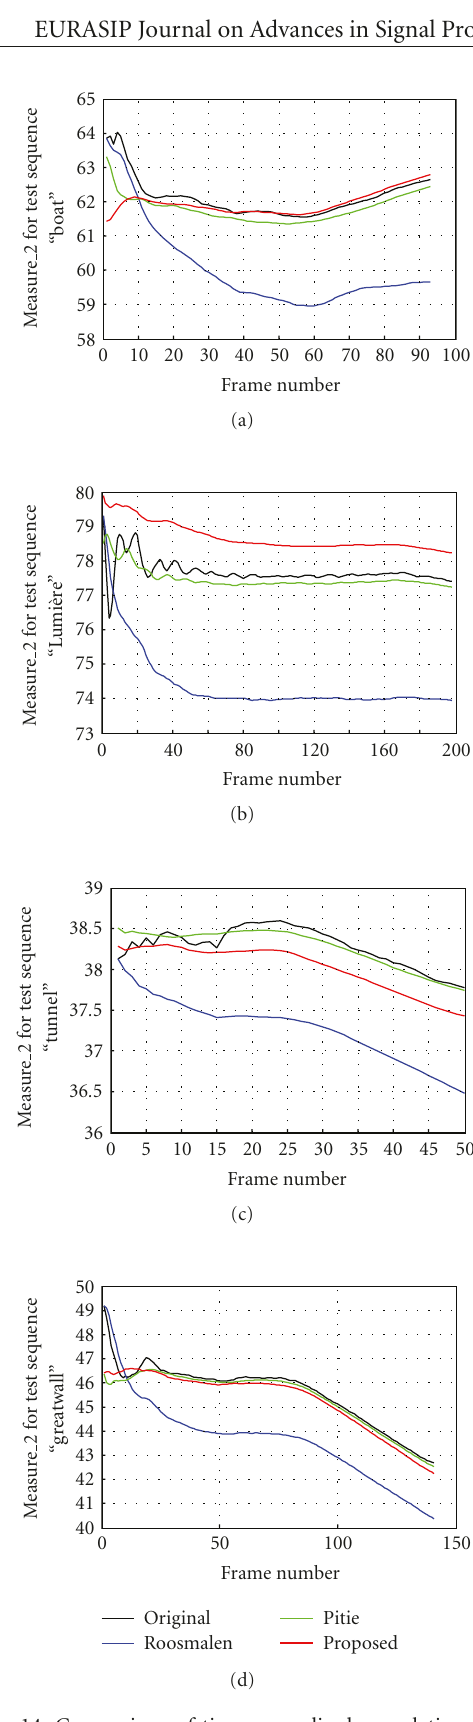
Figure 14: Comparison of time-normalised cumulative standard